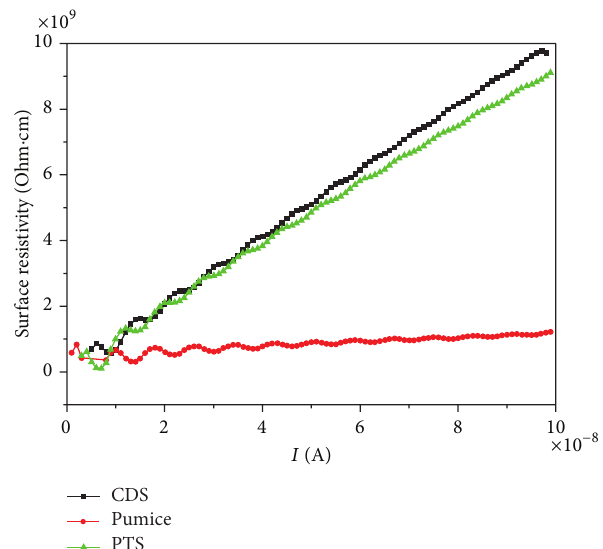
Figure 5: Current biases variation of surface resistivity for the volcanic rocks.